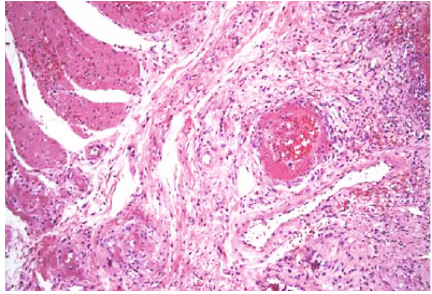
Figure 4: Fibrinoid necrosis of the vascular wall and scattered luminal thrombi present on histopathological